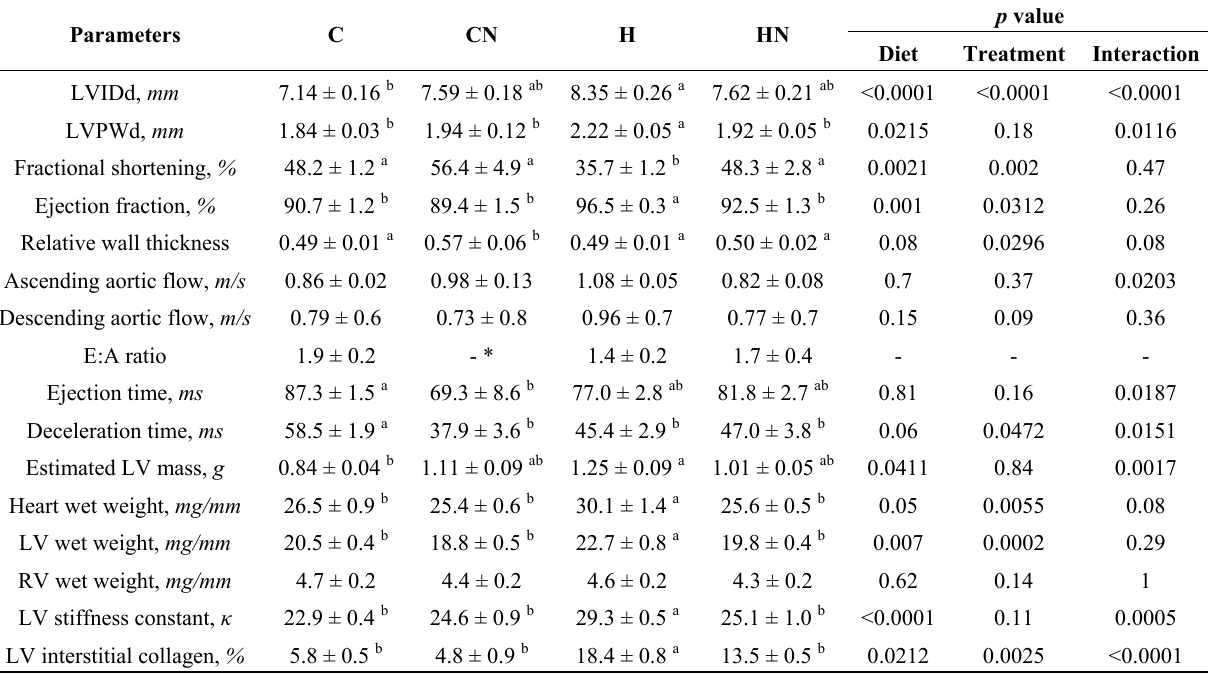
Table 3. Naringin on cardiovascular